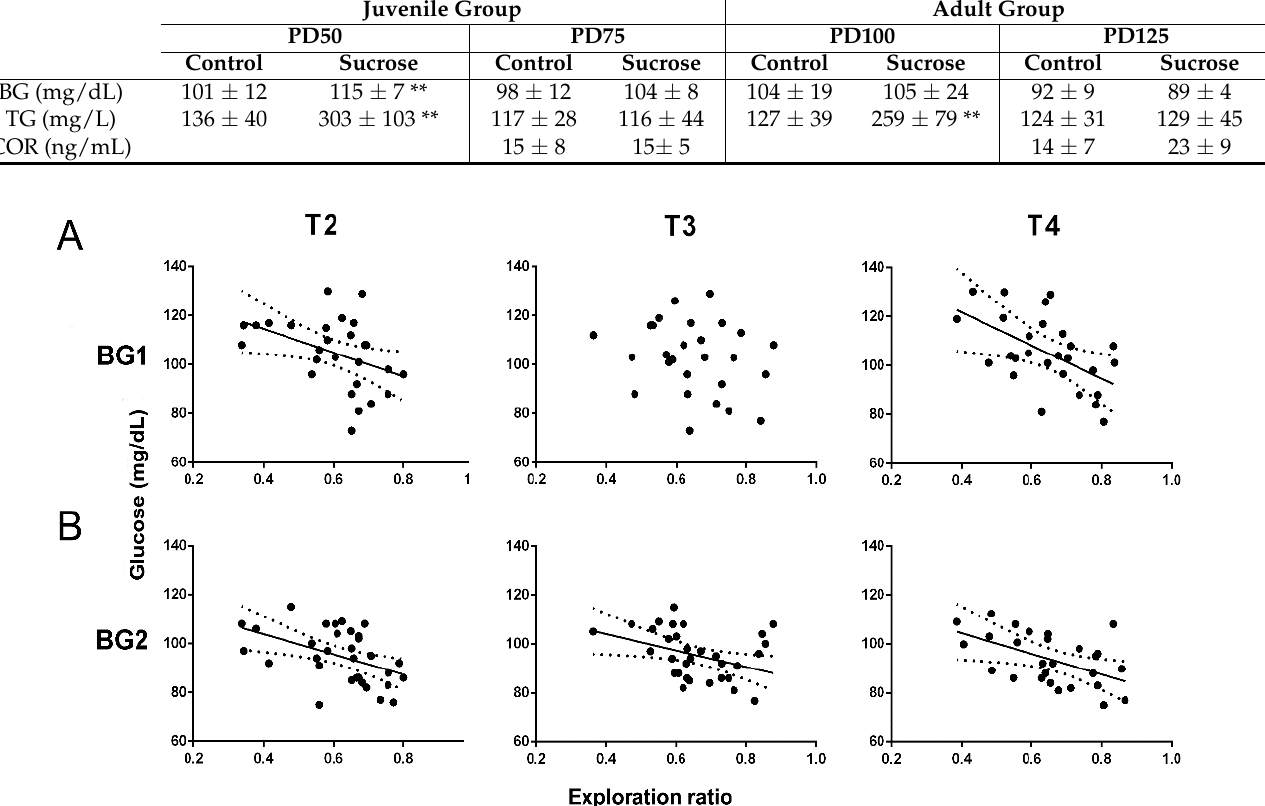
Figure 5. ( A ) Correlations between BG levels 25 days after initiation of sucrose treatment (BG1) and the NOR exploration ratios T2, T3, and T4. Correlation equations of T2, y = 134.1 − 48.54x and T4, y = 148.8 − 67.59x. ( B ) Correlations between the BG levels 25 days after finishing the sucrose treatment (BG2) and the NOR exploration ratios T2, T3, and T4. Correlation equations of T2, y = 120.3 + 41.10x; T3, y = 117.4 + 33.47x and T4, y = 121.2 + 42.08x. Each point represents a value corresponding to an individual animal in the control and sucrose groups of both ages (n = 8). Dotted curves represent the 95% confidence intervals.